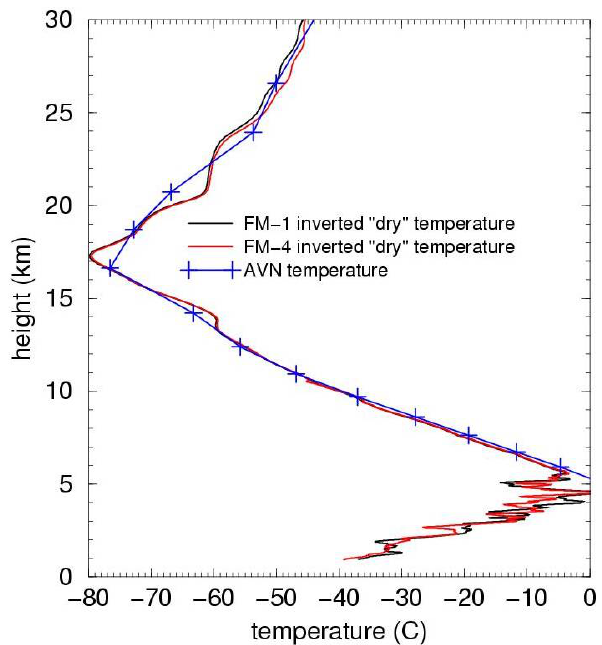
Fig. 7. Two different profiles of “dry temperature” obtained from Flight Module 1 (FM-1) and Flight Module 4 (FM-4) near 20.4 ◦ S 95.4 ◦ W on 23 April 2006, eight days after the launch of COSMIC when the spacecraft were very close together. AVN is a sounding from the NCEP global forecast system analysis interpolated to the location of the COSMIC soundings (source: UCAR CDAAC).